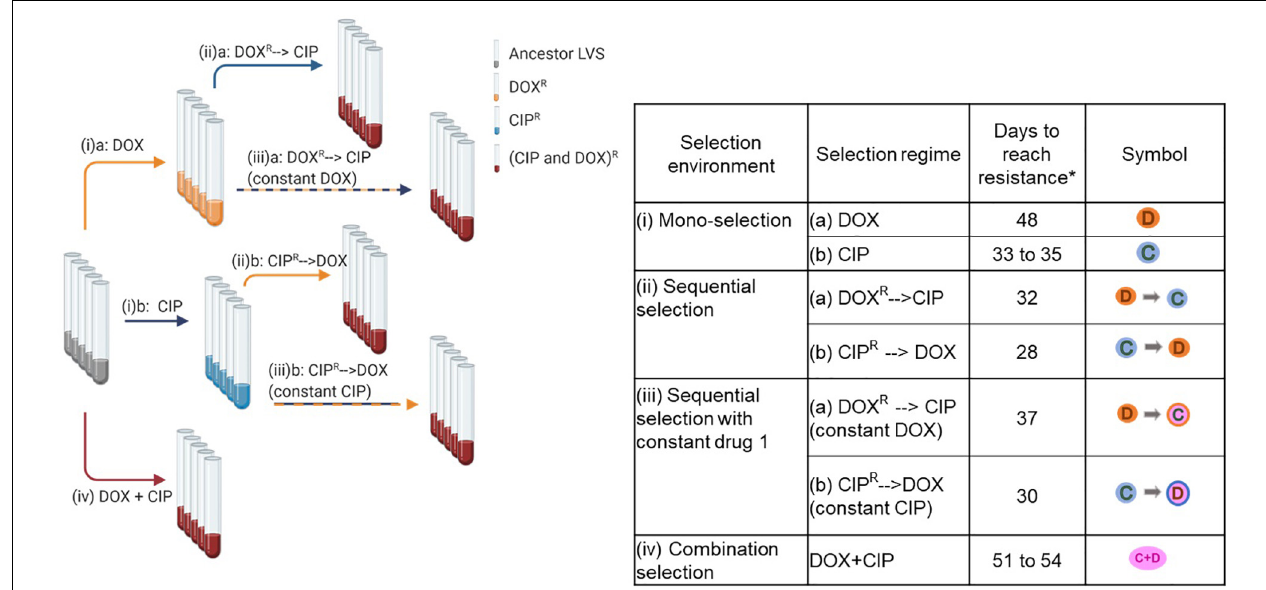
FIGURE 1 | In vitro experimental evolution of LVS to CIP and DOX. The figure on the left shows the scheme of evolution with the various selection regimes and the table on the right shows the four selection environments used, the different regimes for DOX and CIP within each environment, the number of days taken to evolve populations within each regime as well as the symbols used to identify each condition. *Five replicate populations were set up for each selection regime. Created with BioRender.com.